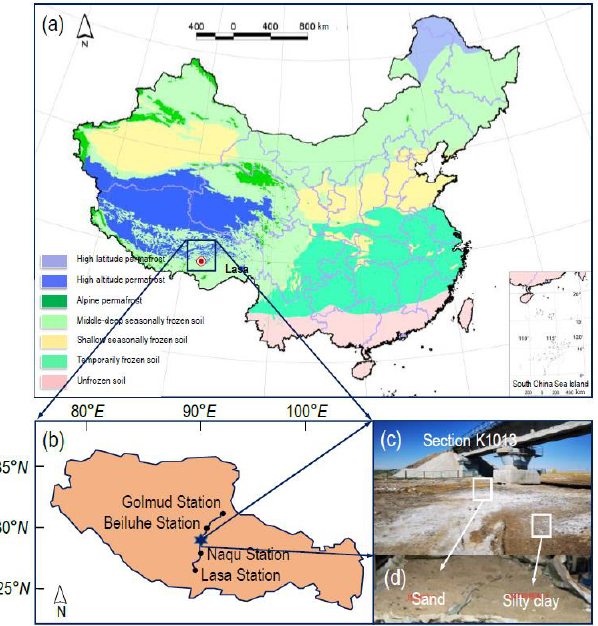
Figure 1. Remoulded fine-grained materials from Section K1013 along the Qinghai−Tibet railway: ( a ) frozen soil map of China; ( b ) Qinghai−Tibet railway; ( c ) section K1013 site; ( d ) remoulded fine-grained materials.